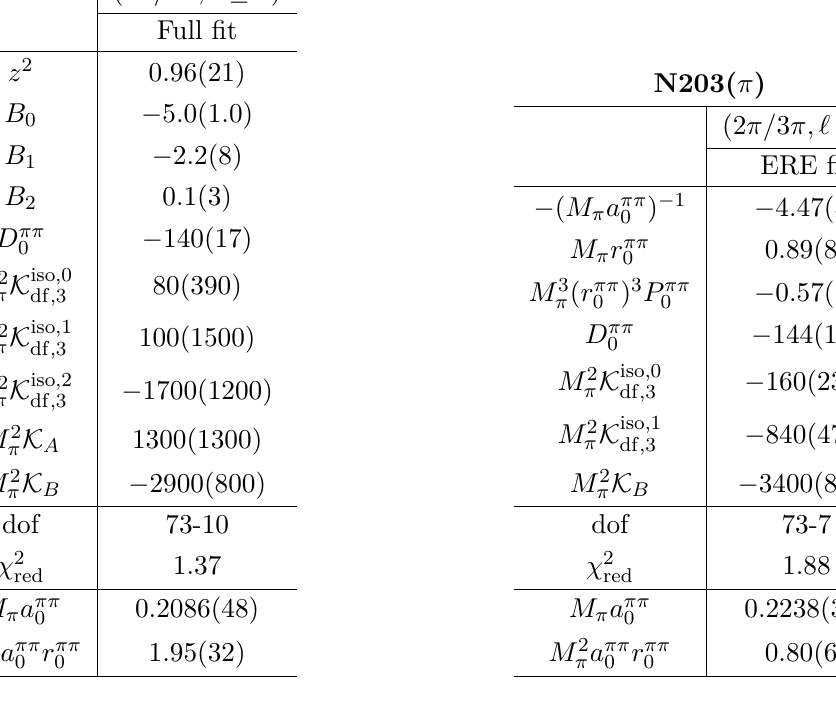
Table 8. Fit for pions on the N203 ensemble using the ERE form of the s -wave phase shift, with M π L and levels as in fits 3–5 of table